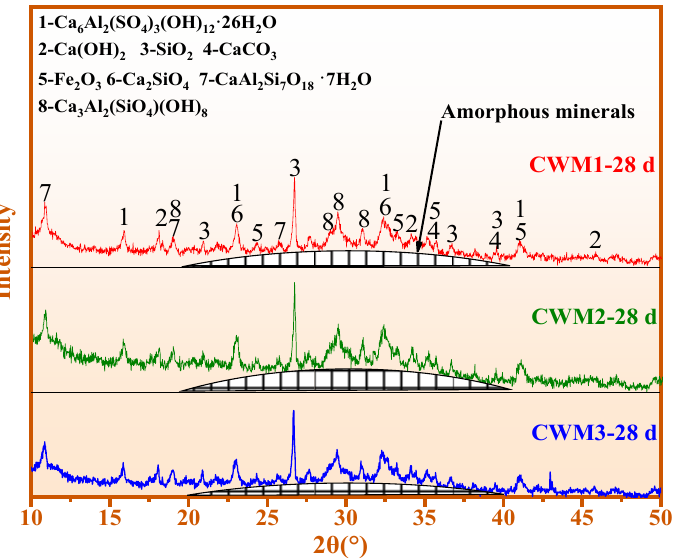
Figure 8. XRD patterns of the three CWMs at 28 days.